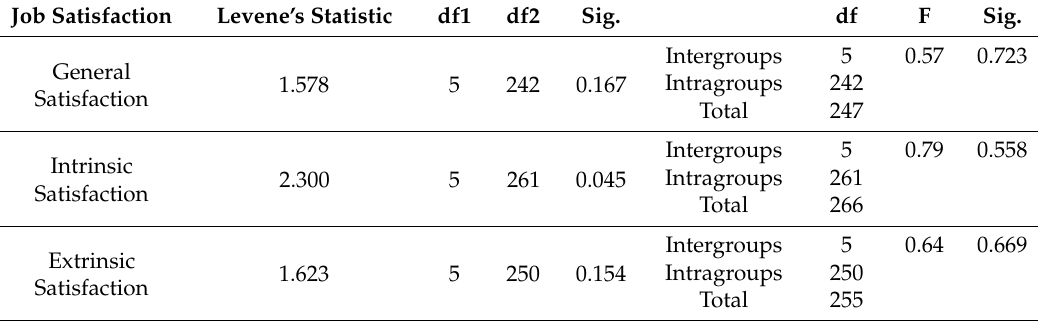
Table 4. Relationship between the general satisfaction dimensions and work experience.